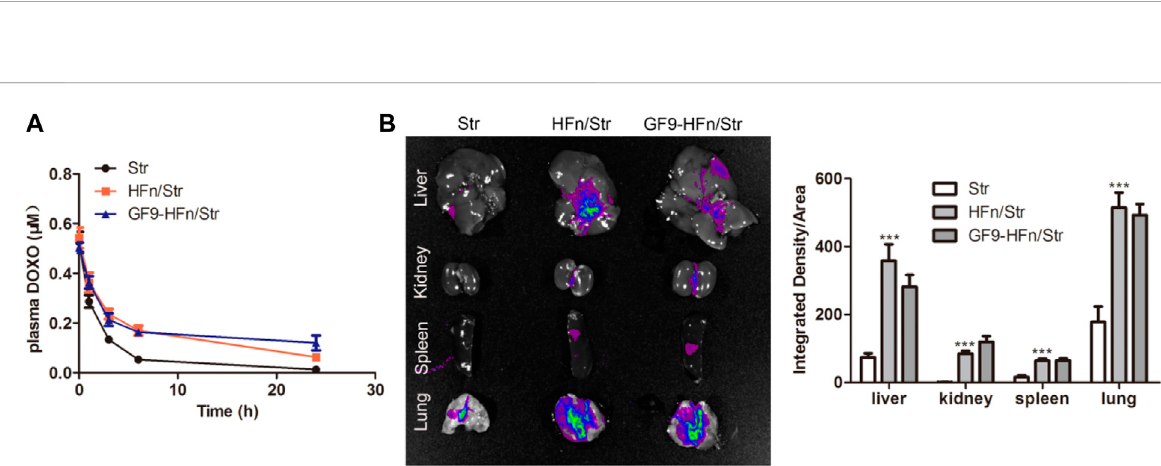
FIGURE 4 The effect of nanomedicines on anti-bacterial. (A) The streptomycin release analysis by nanomedicines at 4 ° C and 37 ° C. (B) The levels of E. coli in nanomedicines were measured. (C) The expression level of AMPs in nanomedicines. *** p < 0.001 vs . Control. ### p < 0.001 vs . Control.